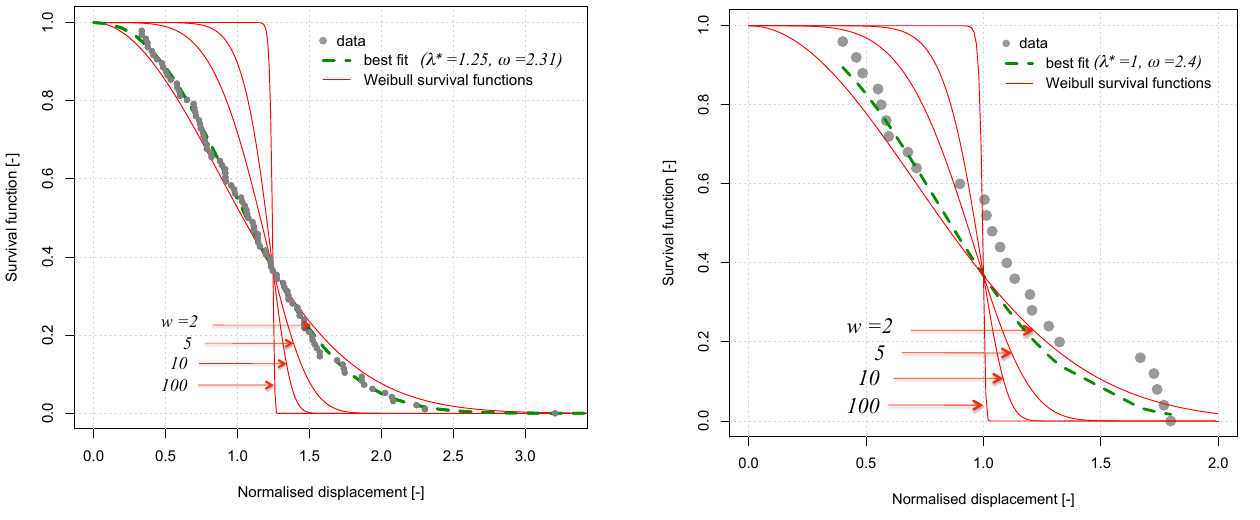
Fig. 5. Survival function for the field pullout tests data. The gray points are the measured data, the green dashed line show the best fit of the Weibull distribution ( λ ∗ = 1 and ω = 2 . 4), and the red lines show the sensitivity of the Weibull function to the exponent ω